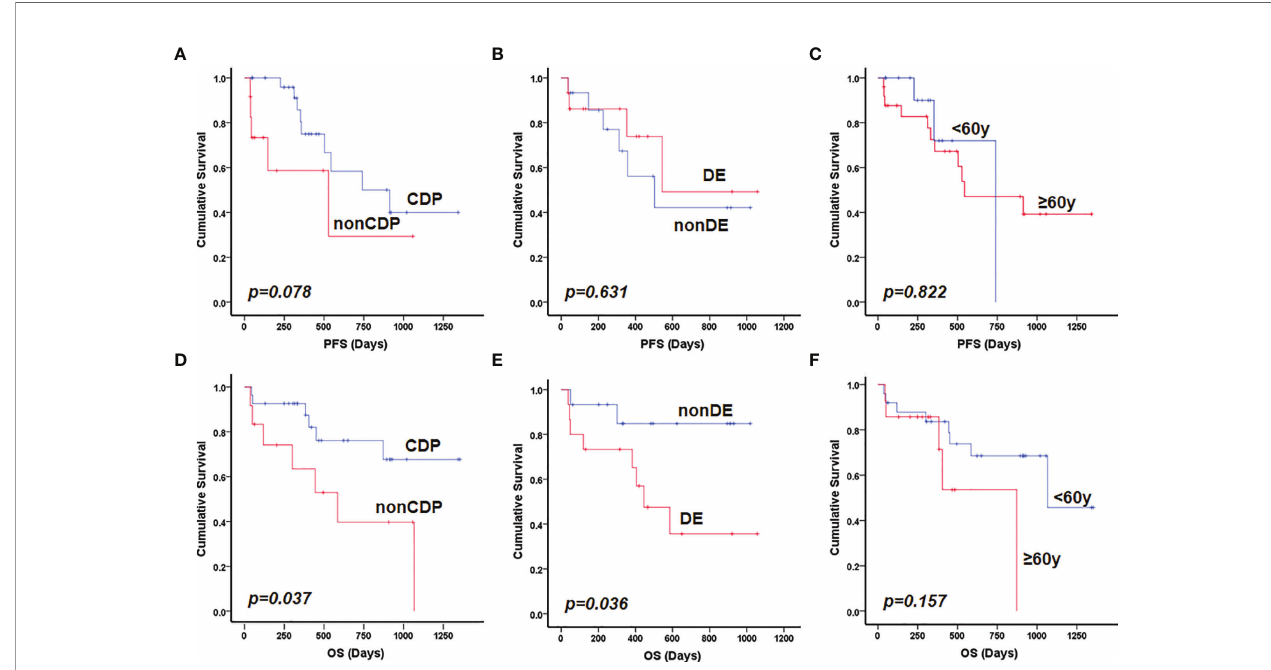
FIGURE 3 | Prognostic factors for patients with primary CNS DLBCL. Patients in the CDP group had longer PFS compared with those in non-CDP group with borderline statistical signi fi cance ( p =0.078) (A) ; MYC and BCL2 double expression (B) and older patient age (>60 years) (C) were not signi fi cantly related to inferior PFS. Both non-CDP group (D) and BCL2 and MYC double expression (E) but not older patient age (>60 years) (F) were signi fi cantly associated with inferior OS in the present cohort by univariate analysis. DE referred to double expression of MYC and BCL2